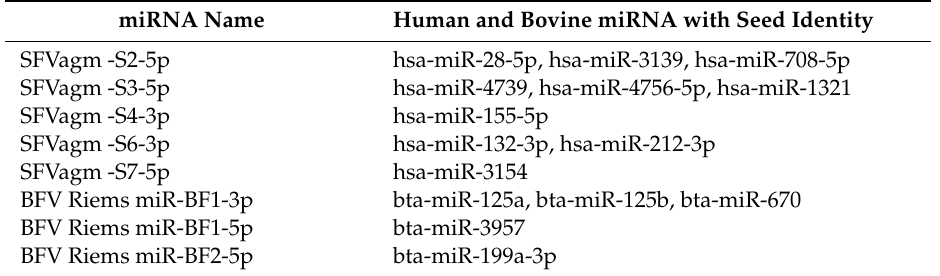
Table 3. Homology of seed sequences of experimentally identified BFV-Riems and simian FV of African green monkey SFV agm ) miRNAs to known miRNAs of other